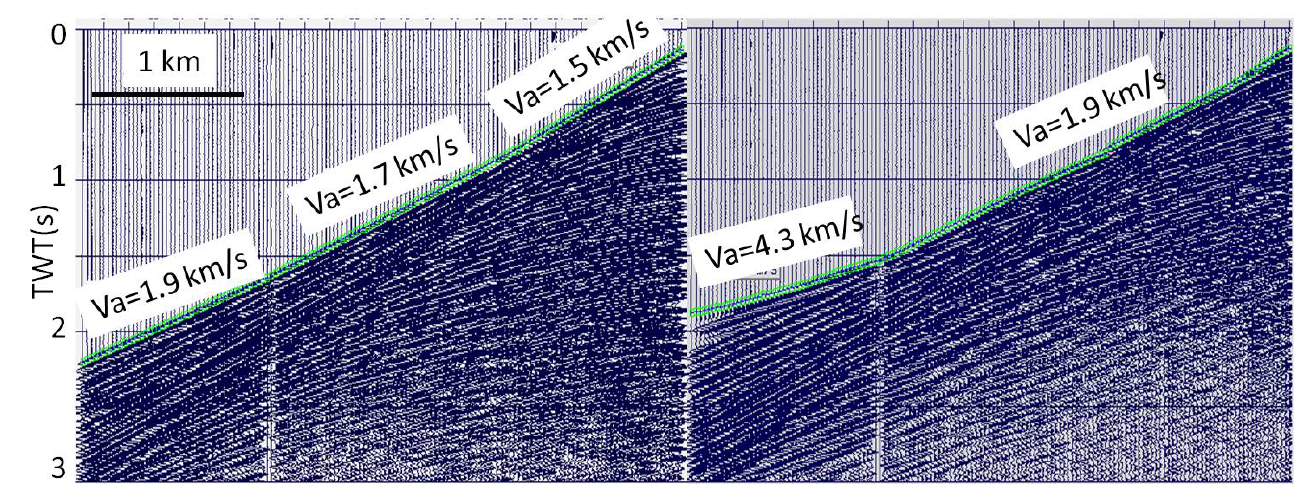
Figure 3. Shot gathers near common depth point (CDP) location 6710 and 7550 (see Figure 2 for CDP locations) showing rapid lateral variation in apparent velocity. Green rectangles indicate travel time